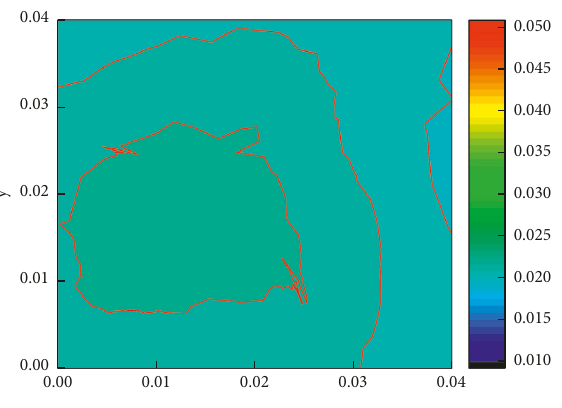
Figure 4: The prediction error distribution of Hanfu pattern features.